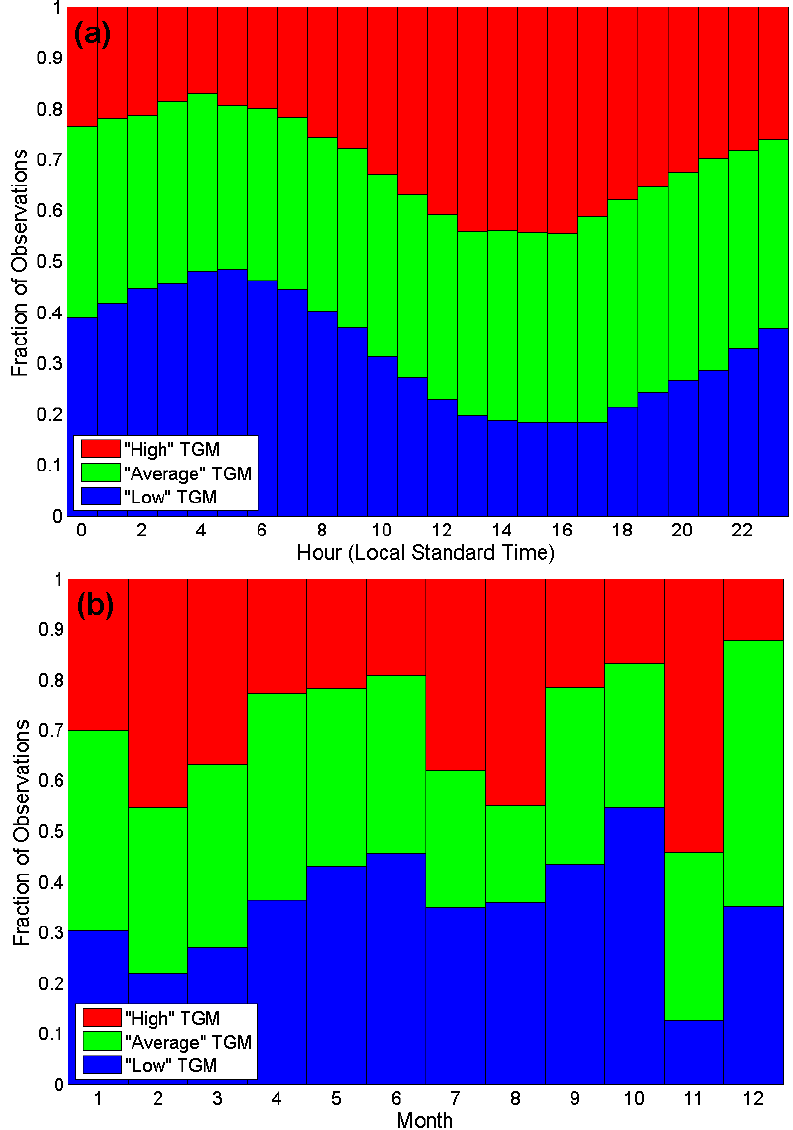
Figure 6. ( a ) Diel and ( b ) monthly fractional distribution of “high”, “average”, and “low” de-trended/seasonally adjusted TGM concentrations as defined in the text. These plots exclude data affected by forest fire